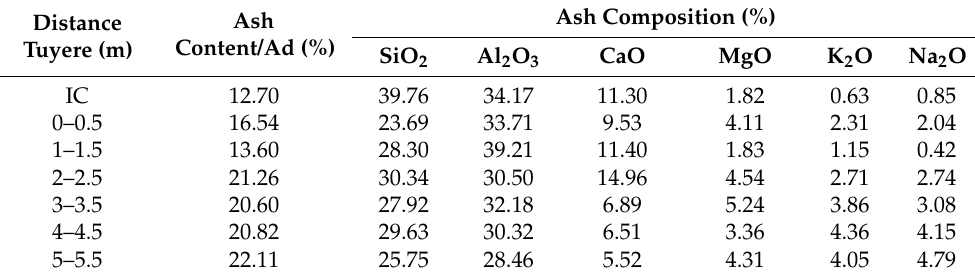
Table 2. Ash content and ash composition of IC and TC analyzed by